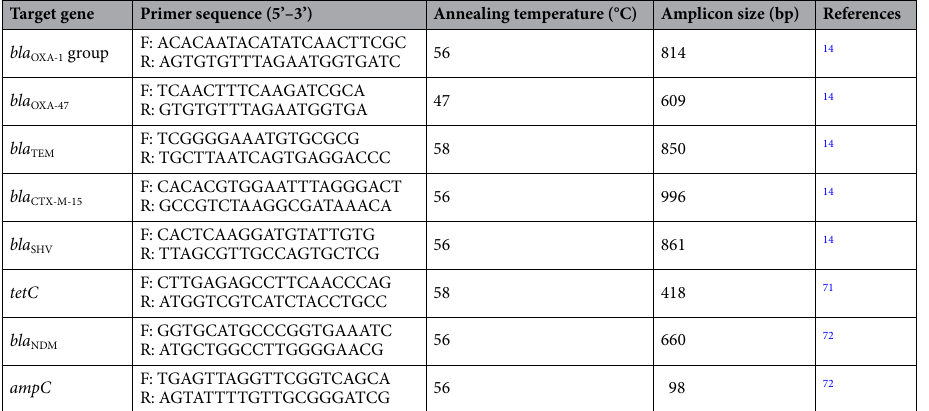
tic clades) based on the presence or absence of 5 genes: chuA, yjaA, tspE4.C2, arpA and trpA. A k-mer-based AMR genes detection method was utilized in PATRIC’s genome annotation service, which assigned functional annotation to broad antibiotic resistance mechanisms. Isolate resistome was analyzed using the Resistance Gene Identifier (RGI) tool of the Comprehensive Antibiotic Resistance Database (CARD), where partial genes were excluded, and the predictions were made with contigs > 20,000 bp. Virulence genes were screened by VFDB, a reference database for bacterial virulence factors (http:// cge. cbs. dtu. dk/ servi ces/ Virul enceF inder/) that contains 139 virulence genes, including 44 ExPEC related genes 77,78 . Mobile genetic elements (MGEs) were predicted using the MobileElementFinder web tool 26 . Pangenome analysis. For pangenomic analysis, we downloaded 46 genome assemblies from NCBI (https:// www. ncbi. nlm. nih. gov/ assem bly, accessed on May 02, 2021) with the search term “(562[Taxonomy ID]) AND Bangladesh”. The test isolate and the 46 assemblies were subjected to Prokka 79 annotation and Roary pangenome pipeline 80 .